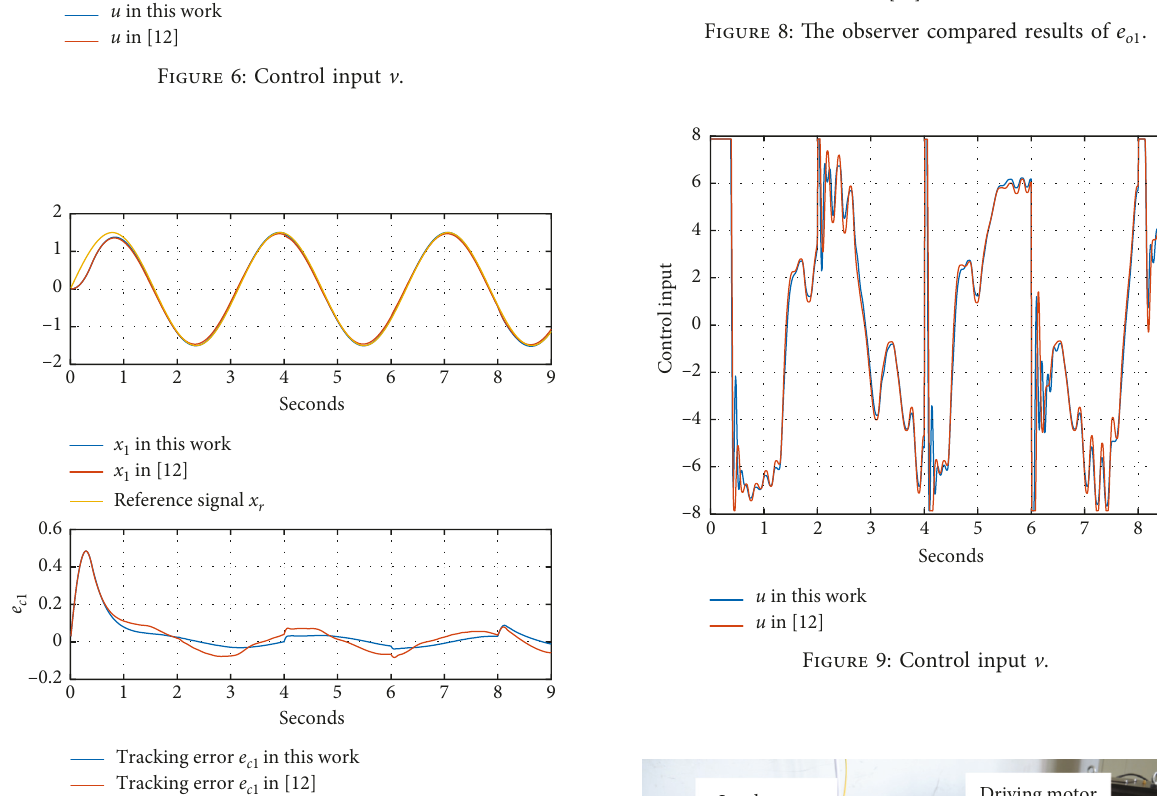
Figure 7: The output tracking responses of x . error e c 1